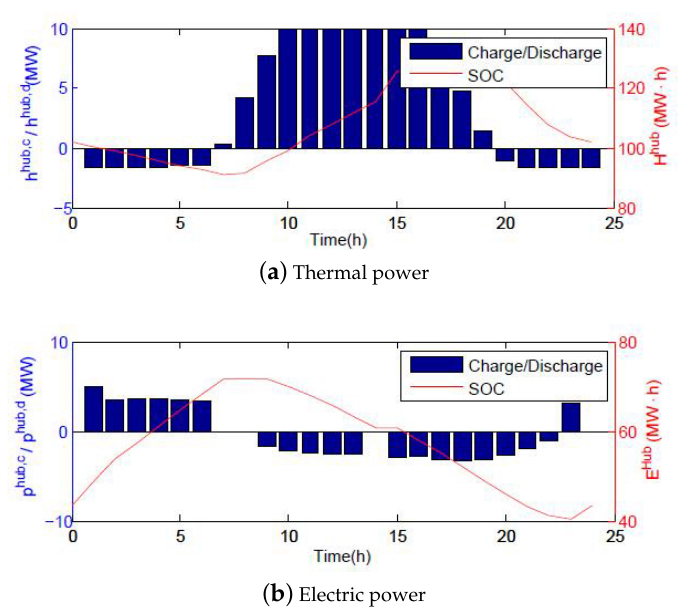
Figure 7. State of the charge of thermal and electric power of the energy router.